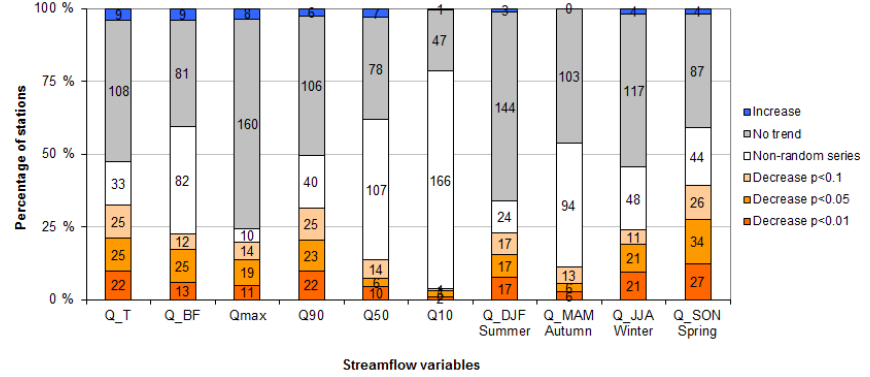
Figure 4. Stacked bar plot summarising the MK trend test results for the 222 HRS stations, with data labels showing the number of sta- tions in each category ( Q T : annual total flow, Q BF : annual baseflow, Q max : daily maximum flow, Q 90 : 90th percentile daily flow, Q 50 : 50th percentile daily flow, Q 10 : 10th percentile daily flow, Q DJF : summer flow, Q MAM : autumn flow, Q JJA : winter flow, Q SON : spring